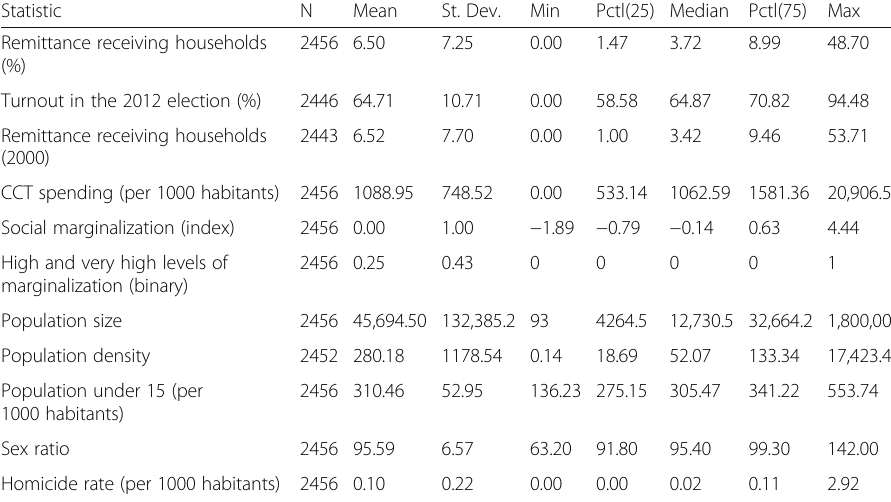
Table 2 Descriptive Statistics. Aggregate Data at the Municipal Level Statistic N Mean